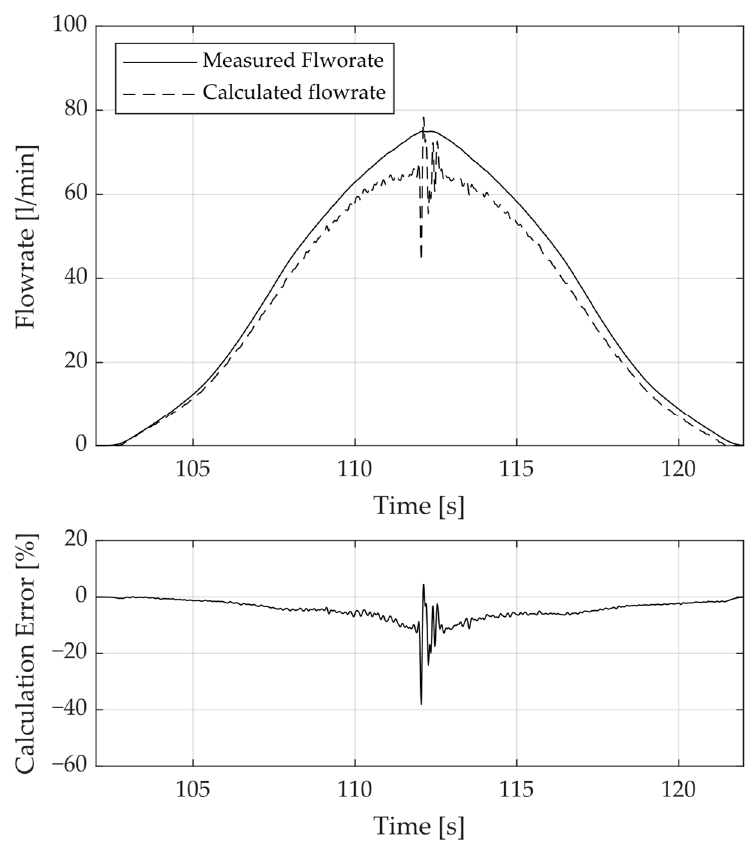
Figure 9. Measured and Estimated Flow Rate while Opening and Closing the